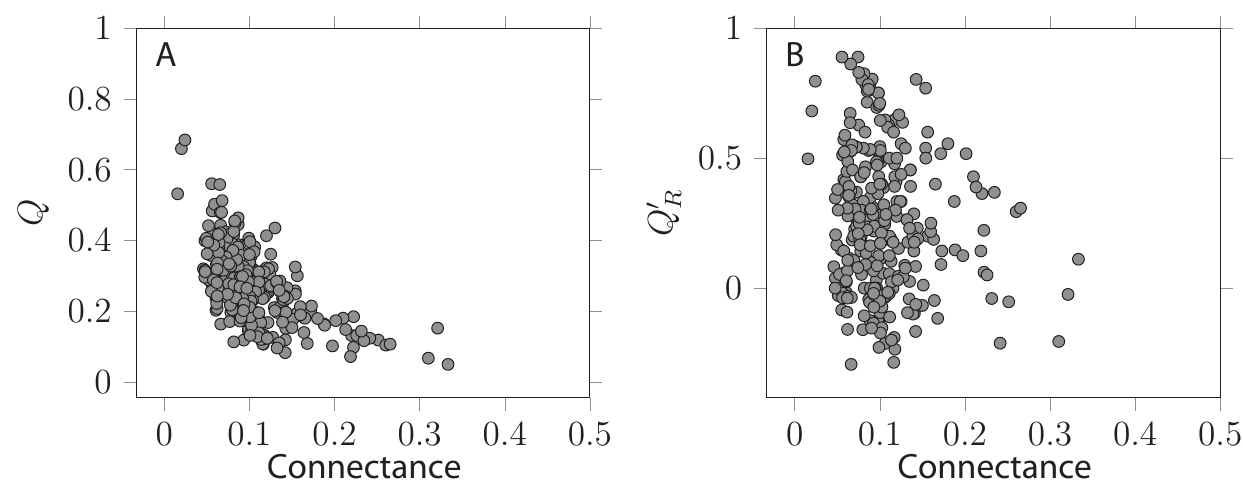
Figure 3. Relationship between the two measures of modularity and network connectance. A . Q is negatively affected by connectance, i.e. densely connected networks are more likely not to be modular. B . Q ′ different networks. Each dot corresponds to a